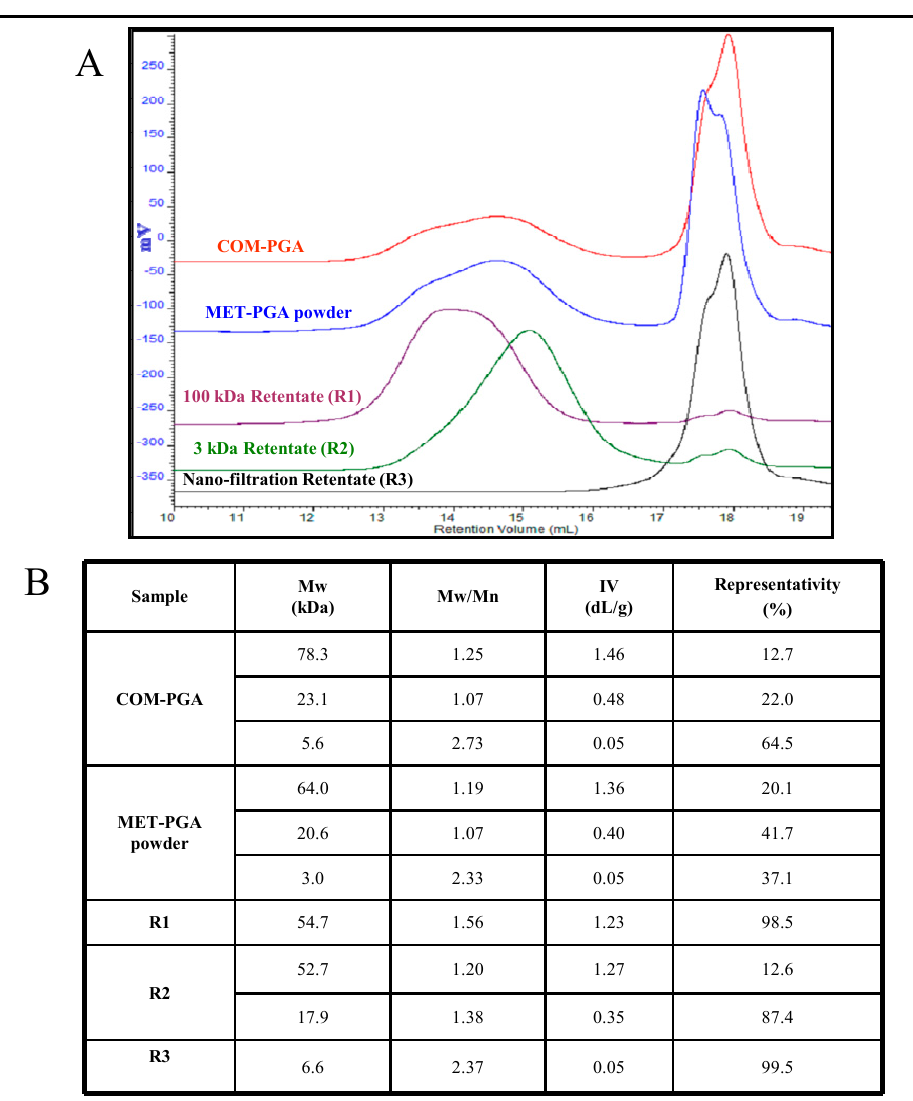
Figure 3. Overlaid SEC-TDA chromatograms of the different γ -PGA samples: refractive index signals of the COM-PGA (red line), MET-PGA powder (blue line), as well as of the R1 (purple line), R2 (green line) and R3 (black line) fractions ( A ). Average Mw, poly-dispersity index (Mw/Mn), intrinsic viscosity (IV) and percentage representativity of each γ -PGA fraction analyzed by SEC-TDA ( B ).